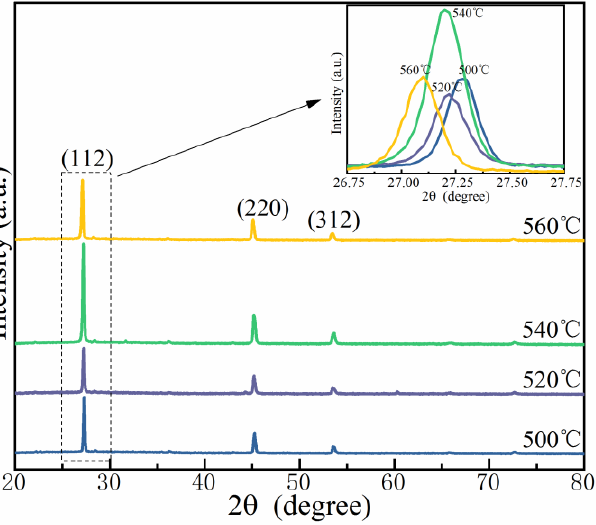
Figure 3. XRD patterns of the CMZTSSe films annealed at 500 °C, 520 °C, 540 °C, and 560 °C; Inset: Enlarged images of (112) peaks of all films.